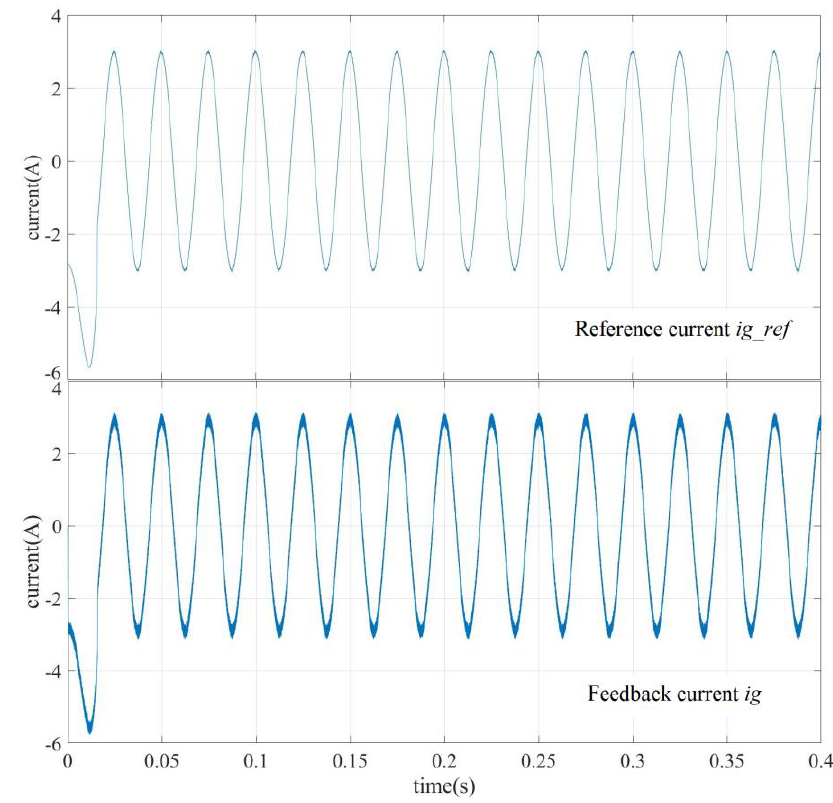
Figure 10. Reference current ig_ref and feedback current ig.